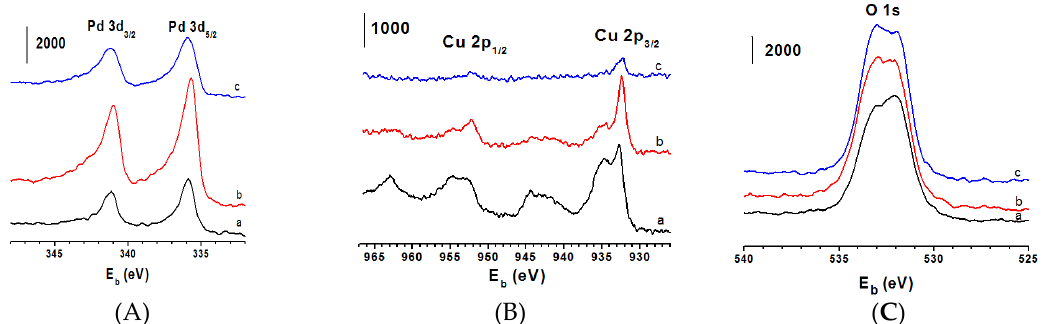
Figure 5. XPS spectra of carbon ‐ supported Pd 21 Cu 79 /C (black, a ), Pd 48 Cu 52 /C (red, b ) and Pd 75 Cu 25 /C (blue, c ) in regions of: Pd 3d ( A ); Cu 2p (B); and O 1s ( C ).